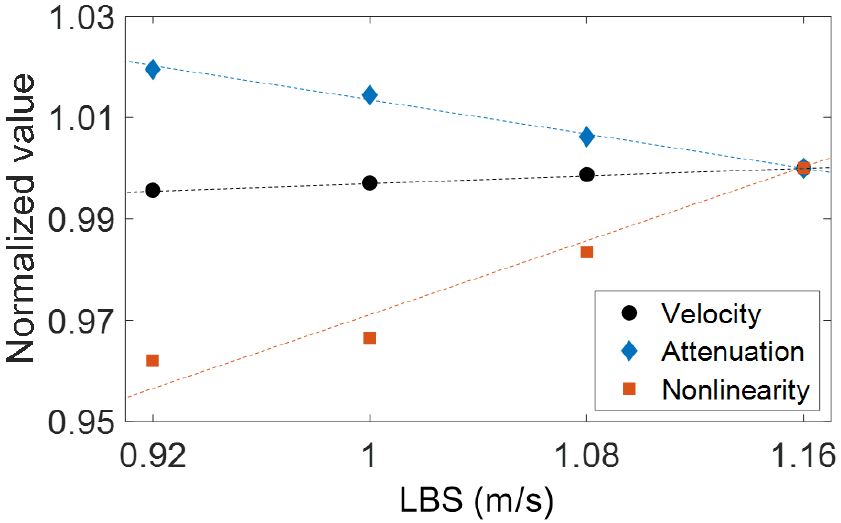
Figure 9. Comparison of the three parameters ( 𝑣 , 𝑎 , and 𝛽′ ) measured under the LBS conditions between 0.92 m/s and 1.16 m/s (State II).